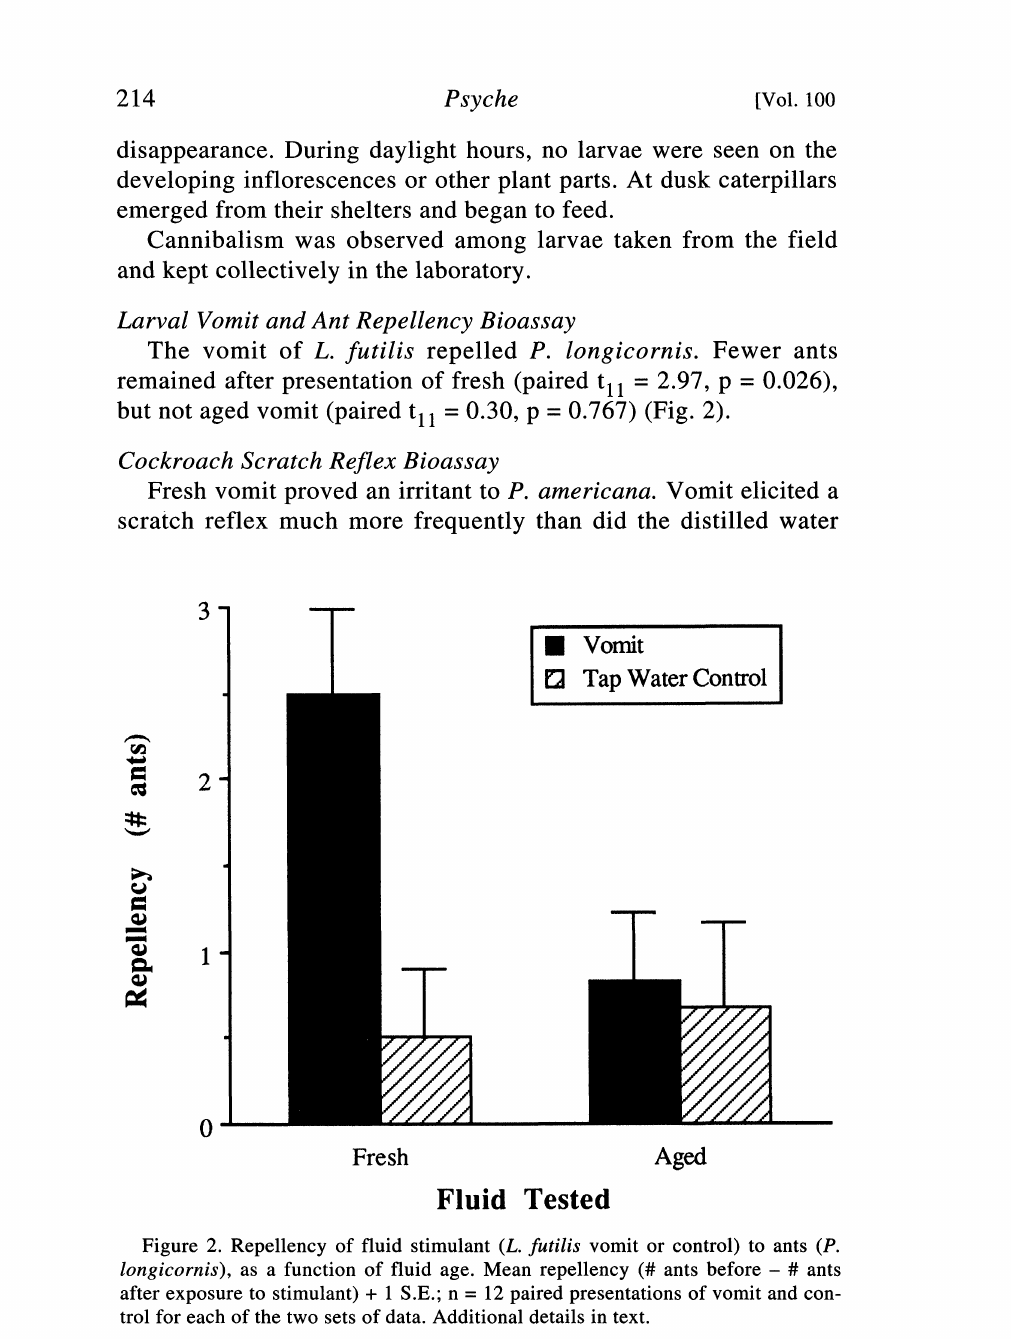
Figure 2. Repellency of fluid stimulant (L. futilis vomit or control) to ants (P. longicornis), as a function of fluid age. Mean repellency (# ants before- # ants after exposure to stimulant) + S.E.; n 12 paired presentations of vomit and con- trol for each of the two sets of data. Additional details in